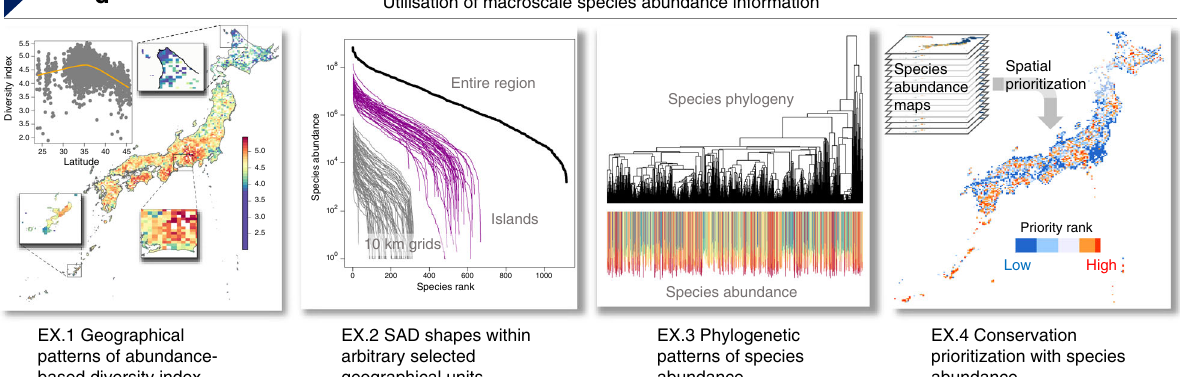
Fig. 1 A framework for estimation of macroscale species abundance. Spatially replicated detection – nondetection observations and various information on species geographic distribution a are integrated in a hierarchical model that links binary observations to underlying species abundance b . A model fi tting yields estimates of individual density of each species in each geographic grid cell, which can then be used to derive estimates of species abundance with the area of suitable habitat c . The results can be used for diverse purposes relevant to, e.g. community ecology, macroecology, biogeography, and applied fi elds of ecology d